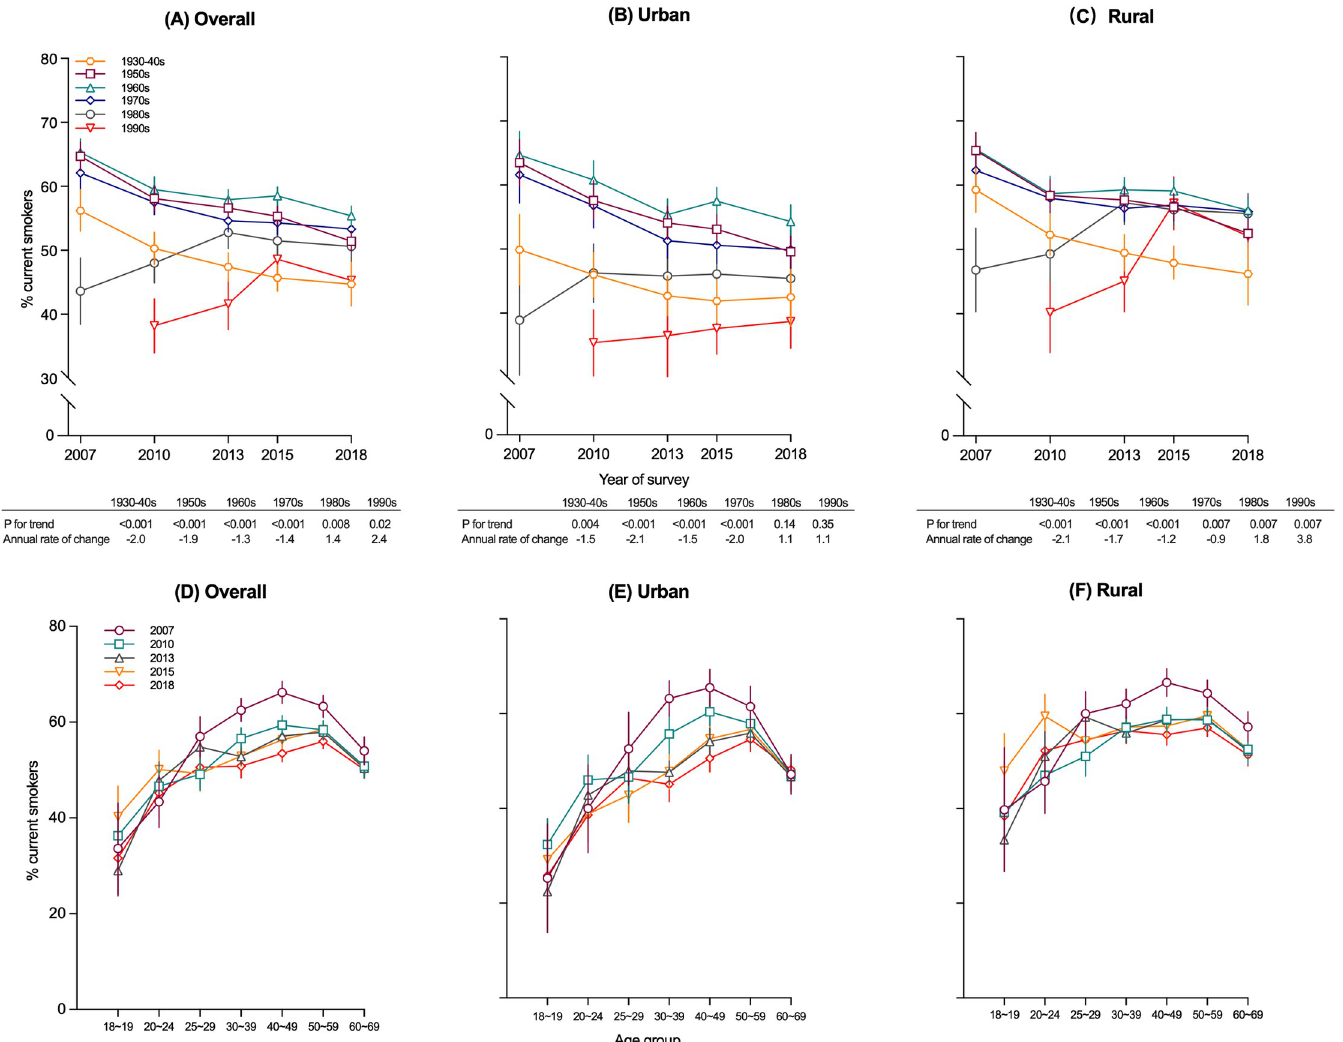
Fig 2. Trends in prevalence of current smoking from 2007 to 2018 among men aged 18–69 years, by year of birth for overall (A), urban (B) and rural (C), or age group for overall (D), urban (E) and rural (F). Data from the 2007, 2010, 2013, 2015, and 2018 CCDRFS. CCDRFS, China Chronic Disease and Risk Factor Surveillance; CI, confidence